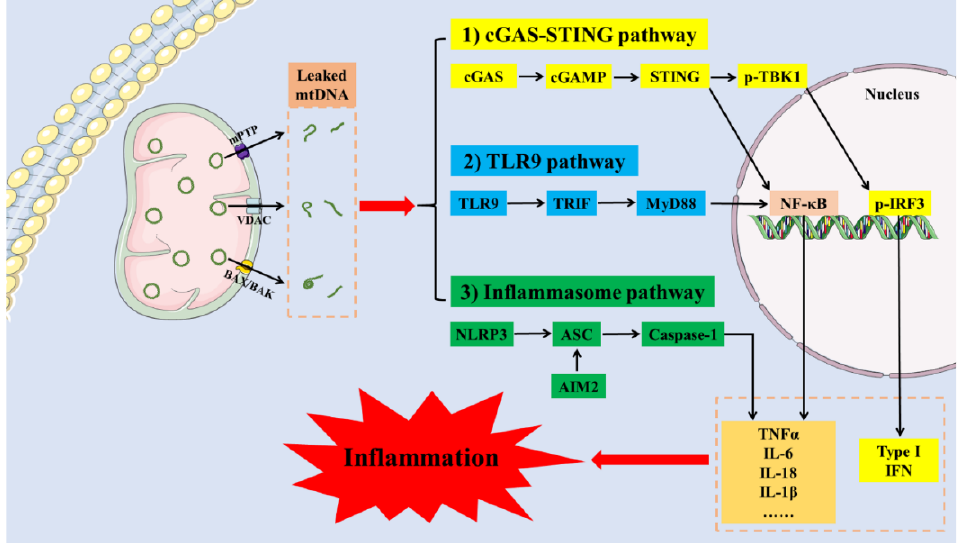
Figure 2. mtDNA leakage induces inflammation activation. mtDNA is released into the cytoplasm through several pathways, such as the BAK/BAX pore, VDAC oligomer pore, and mPTP. mtDNA released into the cytoplasm activates inflammatory responses through multiple signaling pathways, including cGAS-STING, TLR9, NLRP3, and AIM2 inflammasome. (cGAS, cyclic GMP-AMP syn- thase; STING, stimulator of interferon genes; cGAMP, cyclic guanosine monophosphate-adenosine monophosphate; p-TBK1, phospho-TANK-binding kinase-1; TLR9, toll-like receptor 9; TRIF, TIR domain-containing adapter-inducing IFN β ; MyD88, myeloid differentiation protein 88; NLRP3, nod-like receptor pyrin 3; ASC, apoptosis associated speck like protein; AIM2, absent in melanoma 2; VDAC, voltage-dependent anion channel; mPTP, mitochondrial permeability transition pore; TNF α , tumor necrosis factor α ; IL-6, interleukin-6; IL-18, interleukin-18; IL-1 β , interleukin-1 β ; NF- κ B, nuclear factor kappa-B; p-IRF3, phospho-interferon regulatory factor-3; IFN,